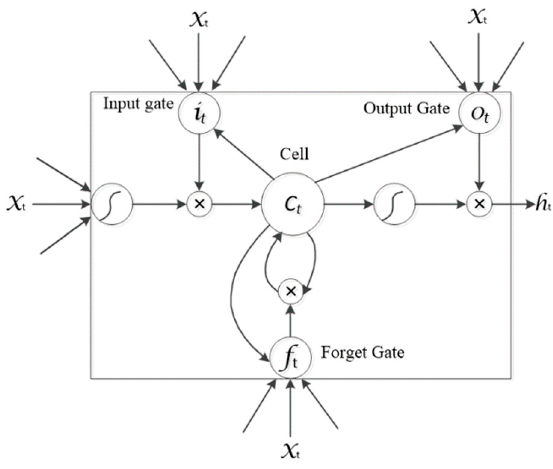
Figure 2. Architecture of the LSTM memory. 197